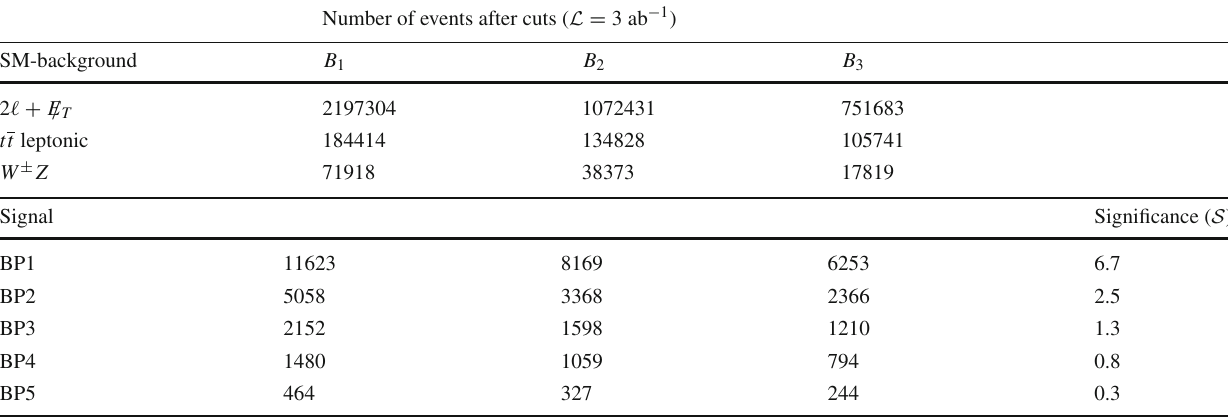
Fig. 7 Normalised distributions of p (cid:3) 1 Table 10 The cut-flow for signal and backgrounds for 2 (cid:3) + E T / channel along with the significance for BP1, BP2, BP3, BP4 and BP5 at 14 TeV LHC for 3 ab − 1 integrated